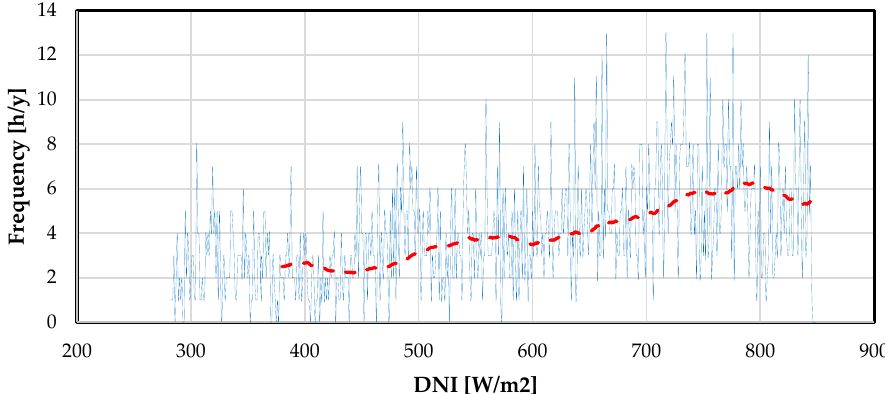
Figure 12. DNI frequencies in Rome for the period between 2004 and 2005 and the moving average of DNI (red line).